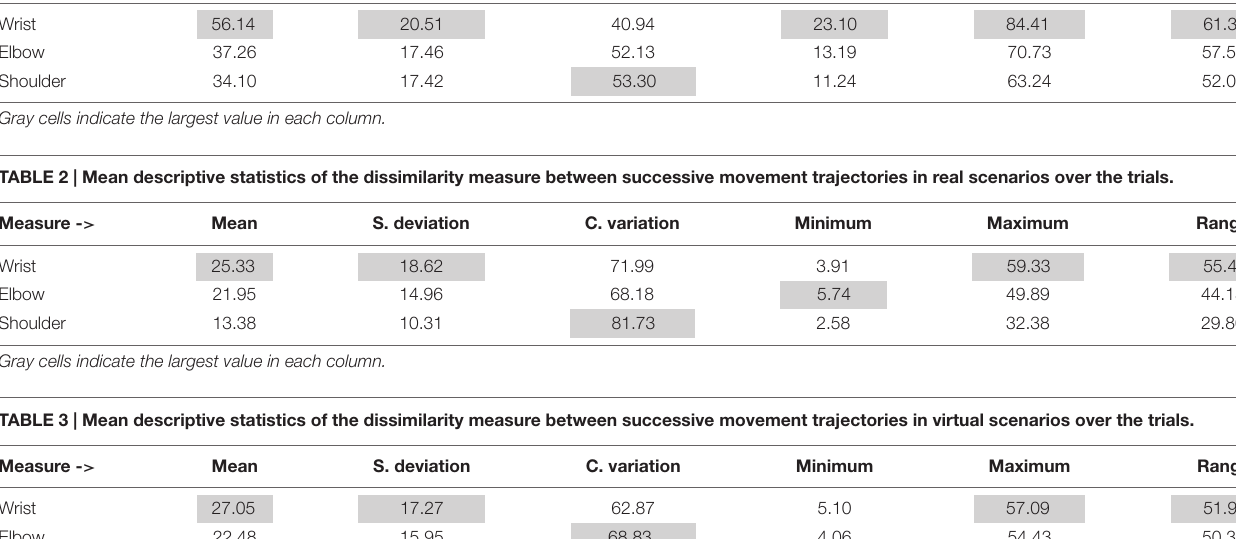
TABLE 1 | Mean descriptive statistics of the dissimilarity measure between movement trajectories in real and virtual scenarios over the trials. Measure - >